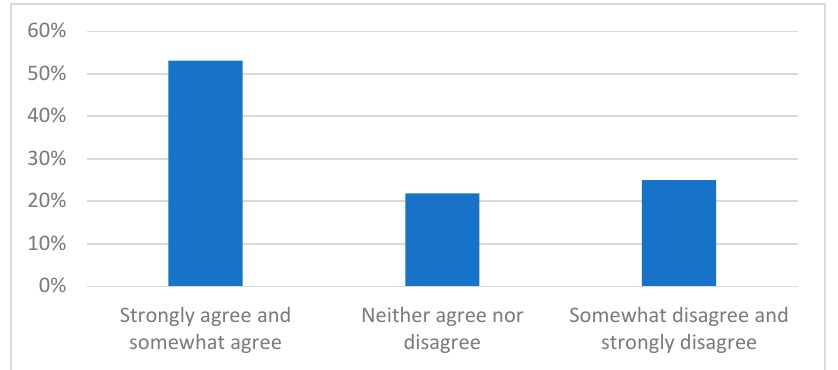
Figure 6. Is the IMO 2021 Cyber regulation the answer to cyber security for shipping? (Asia and Europe).